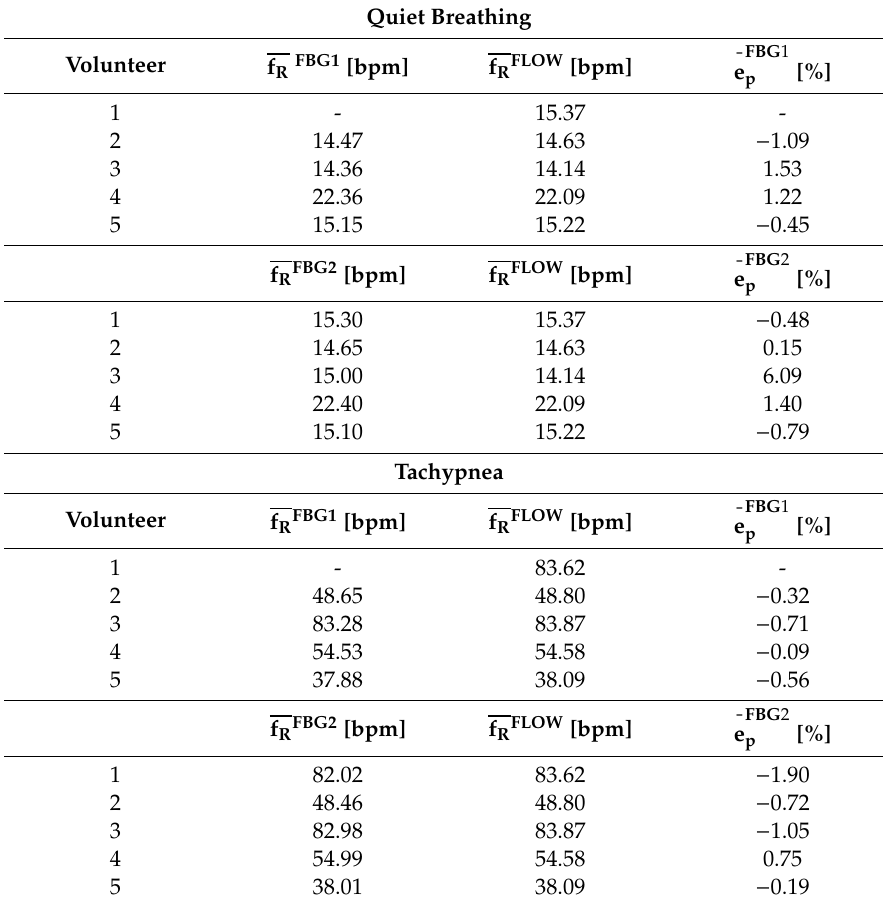
Table 2. Mean f R values and percentage errors (e P ).